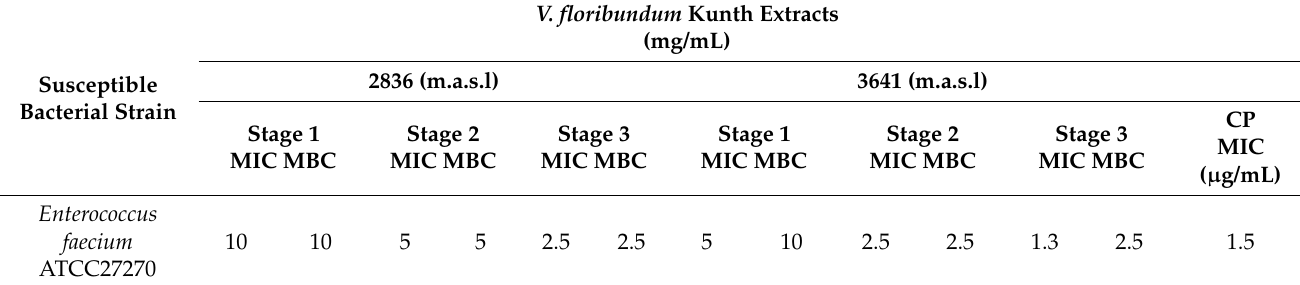
Table 6. Minimum inhibitory concentrations (MICs) and minimal bactericidal concentrations